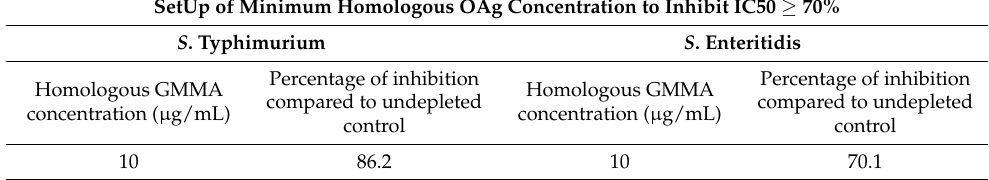
Table 2. Minimum homologous GMMA concentration able to inhibit IC50 ≥ 70% for each of the two